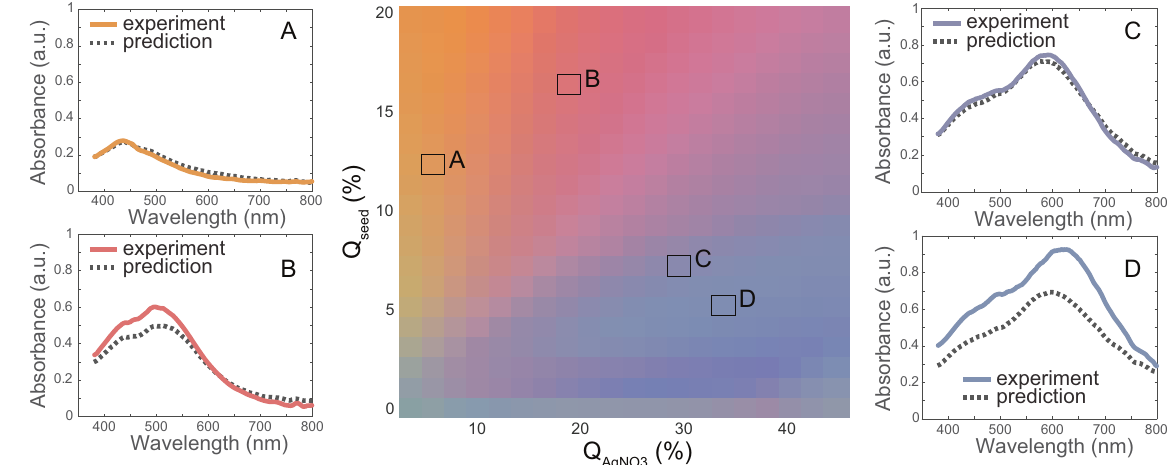
Fig. 5 Knowledge extraction on the silver nanoprism synthesis. Map of the AgNPs colours predicted by the DNN teacher in the { Q AgNO space, for a fi xed value Q PVA = 16%, Q TSC = 6.5% and Q total = 850 µL/min, corresponding to the conditions of the DNN best performance in run 8. Predicted spectra (dotted grey line) were extracted in four regions of the space ( A , B , C , and D ) and compared to experimental spectra (plain coloured line) obtained for similar